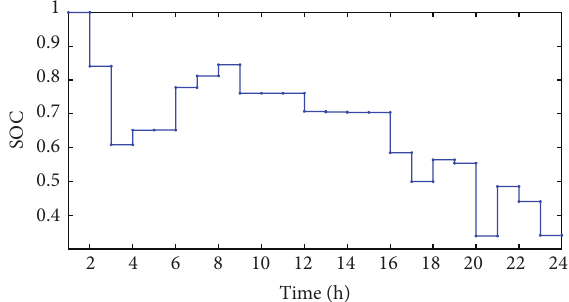
Figure 12: SOC of storage battery at the least total loss expenses condition in 24 hours.